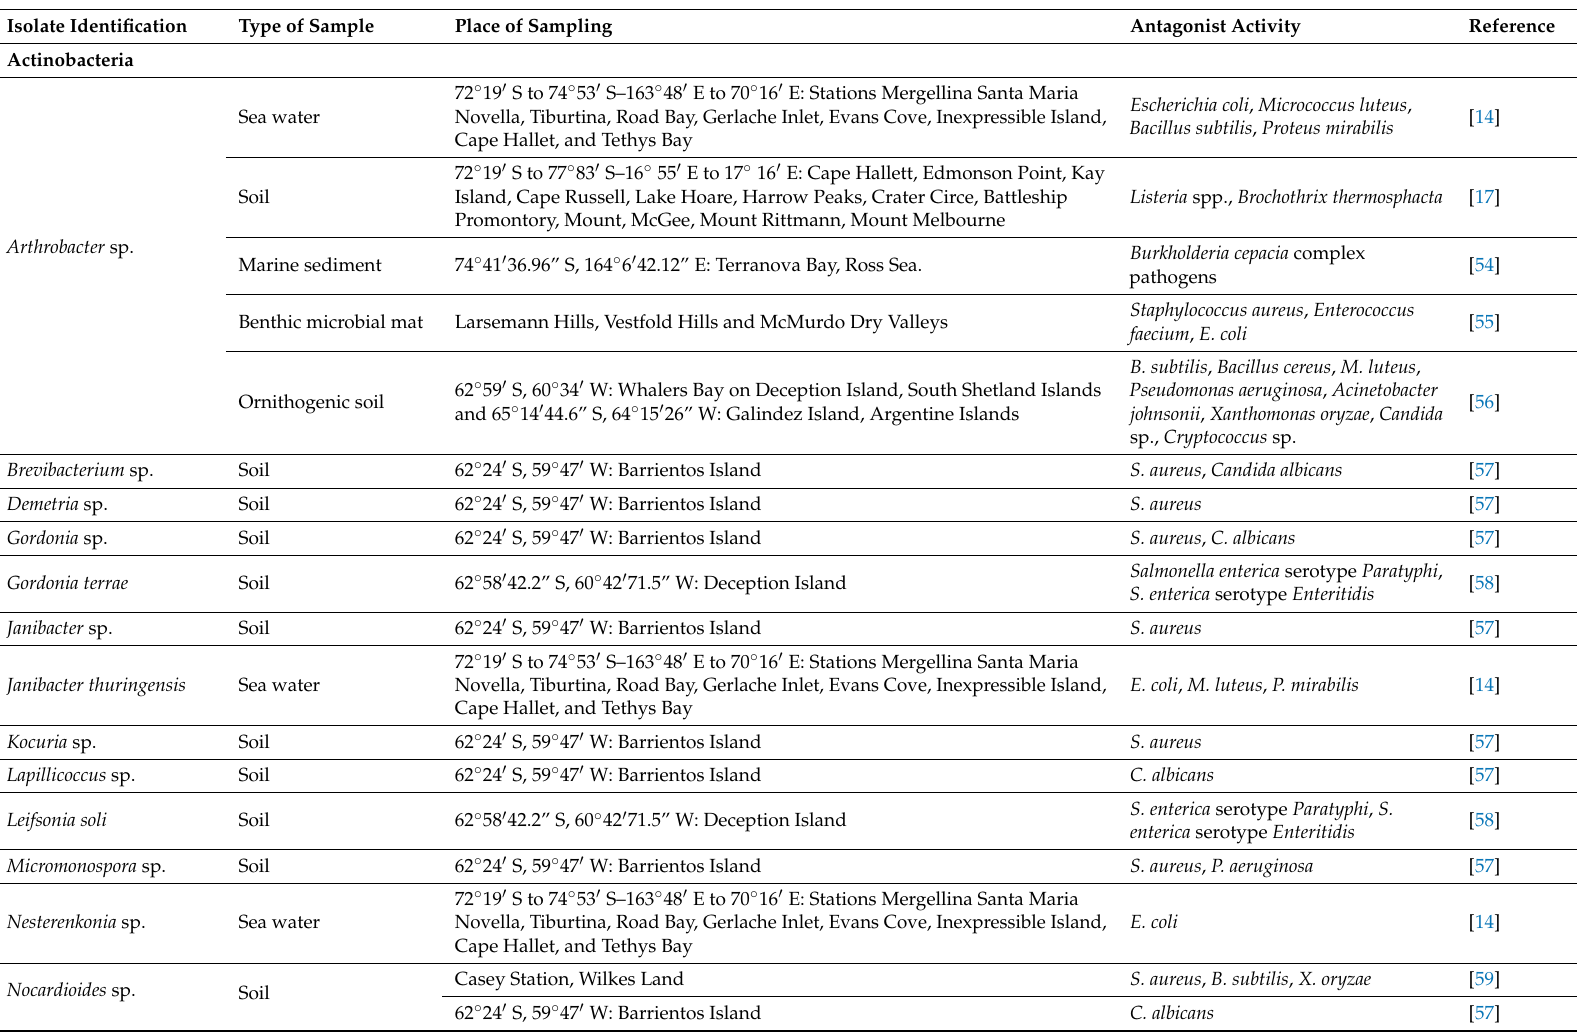
Table 1. Antimicrobial substance-producing bacteria from Antarctic